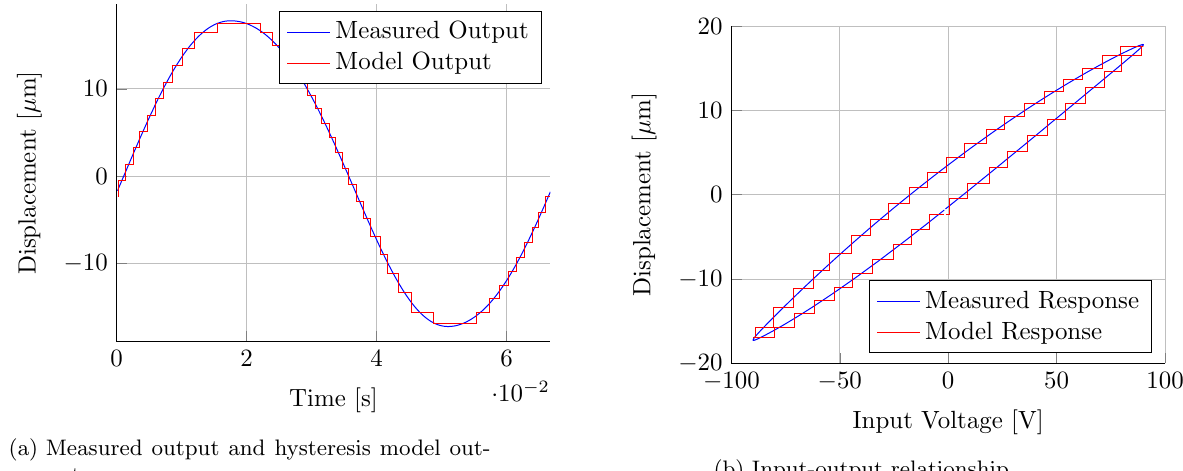
Figure 8: Model output when identifying using a 20 Hz sine wave, with 90 V amplitude, with n h = 20 as discretization level.